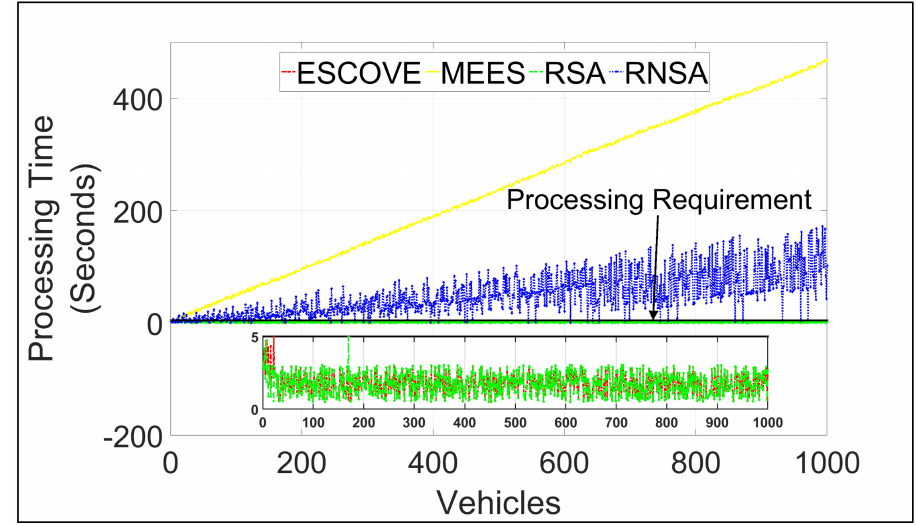
Figure 10. Processing times of requests using ESCOVE, MEES, RSA, and